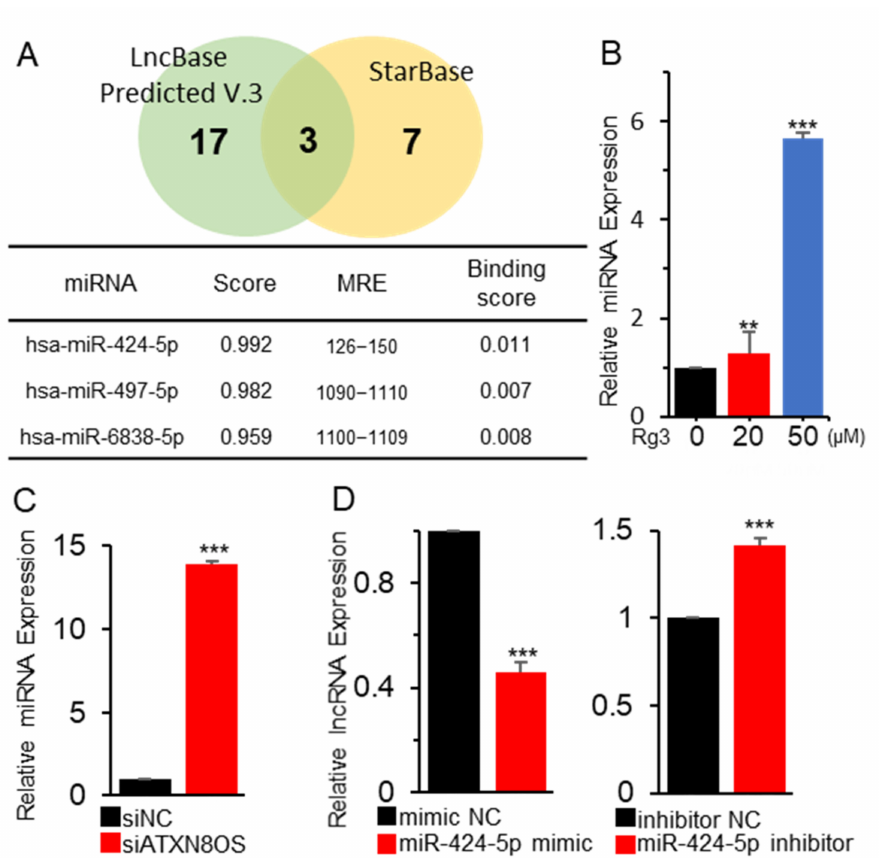
Figure 2. ATXN8OS and miR-424-5p sponge each other. ( A ) Three miRs that could potentially bind ATXN8OS were screened in silico using two miR-prediction databases (LncBase Predicted v.3 and StarBase). ( B ) miR-424-5p exhibited the highest binding score and was therefore examined to characterize its regulation by Rg3. MCF-7 cells were treated with Rg3, and the RNA expression was quantified by qRT-PCR. ( C , D ) The association between the ATXN8OS and miR-424-5p expression was monitored by examining the expression of each RNA after inhibiting ATXN8OS using siRNA ( C ) and overexpressing (40 µ M) or inhibiting miR-424-5p (20 µ M) ( D ). All experiments were performed in triplicate, and the values are presented as the mean ± SE. Testing was done using siNC, negative control siRNA (40 µ M); siATXN8OS, ATXN8OS-specific siRNA (40 µ M); mimic NC, negative control mimic for miR-424-5p (40 µ M); and inhibitor NC, negative control inhibitor for miR-424-5p (20 µ M). ** p < 0.01, *** p <